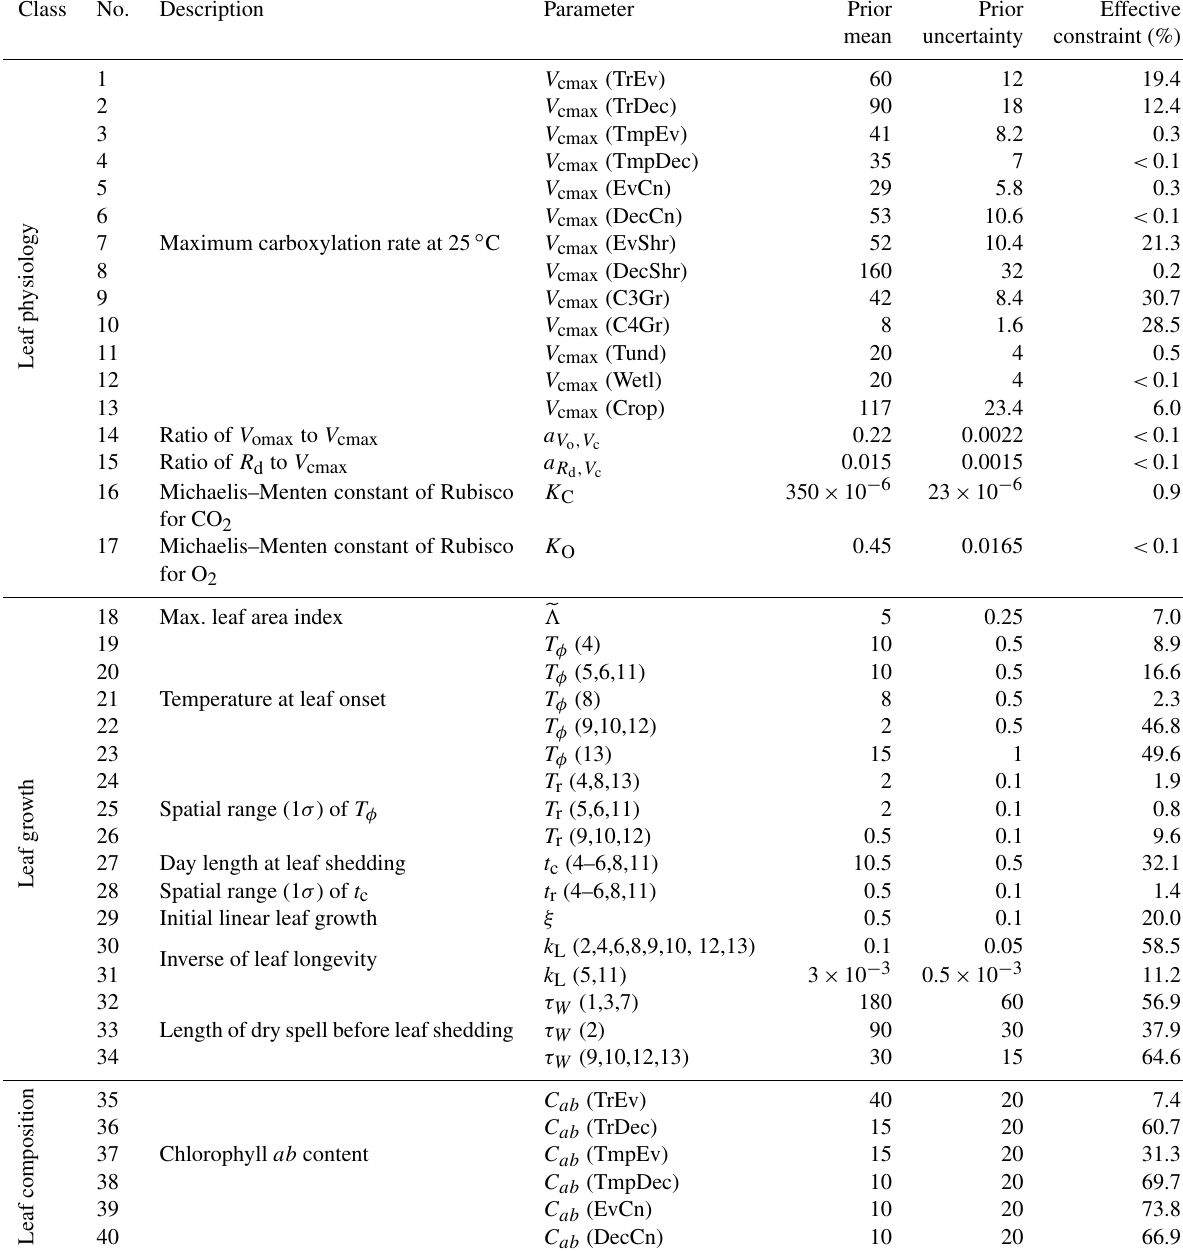
Table A1. BETHY-SCOPE process parameters along with their prior and optimized uncertainties following SIF constraint, represented as 1 standard deviation. Relative uncertainty reduction (i.e. effective constraint) is reported for the error propagation with low-resolution and high-resolution SIF observations. Units are as follows: V cmax – µmol ( CO 2 ) m − 2 s − 1 ; a V K O – bar; e (cid:51) – m 2 m − 2 ; T φ – ◦ C; T r – ◦ C; t c – hours; t r – hours; ξ – d − 1 ; k L – d − 1 ; τ W – days; C ab – µgcm − 2 ; C dm – gcm − 2 ; C sm